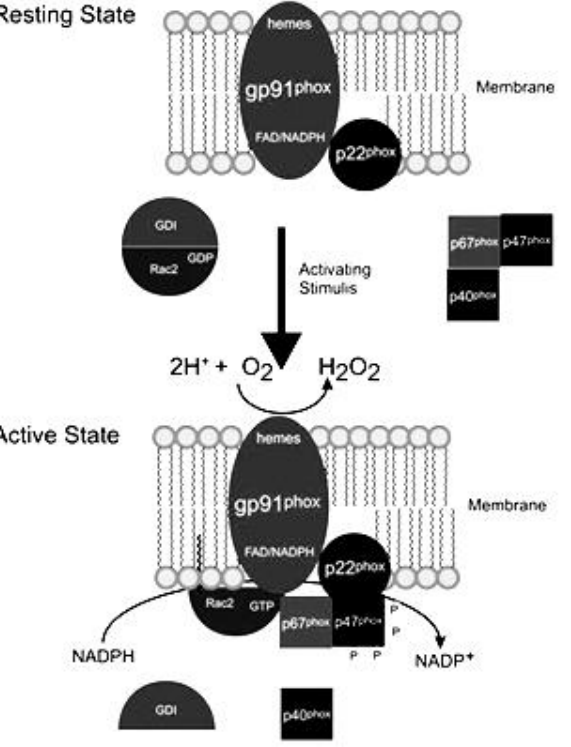
FIGURE 2. NADPH oxidase ROS